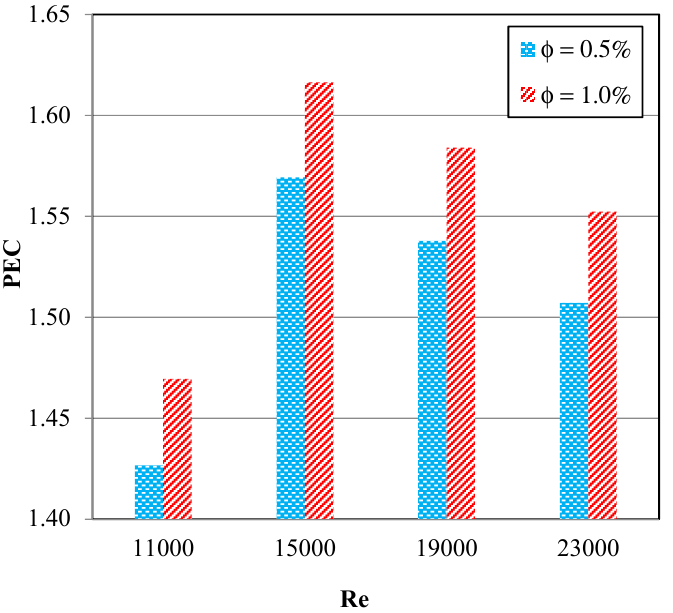
Figure 33. PEC variation versus different Reynolds numbers for optimum configurations of Case D.